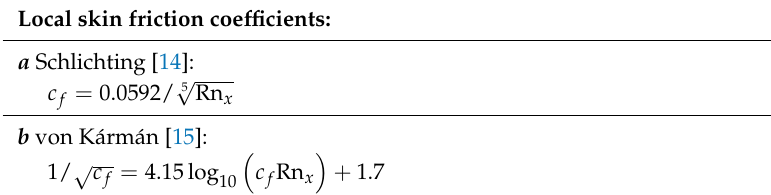
Table 1. Exemplary values mentioned in the literature for the viscous drags c f and c F for one side of a flat plate with fully turbulent flow. The first five relationships assume a hydrodynamically smooth surface, the others take the relative roughness k / c of the surface into